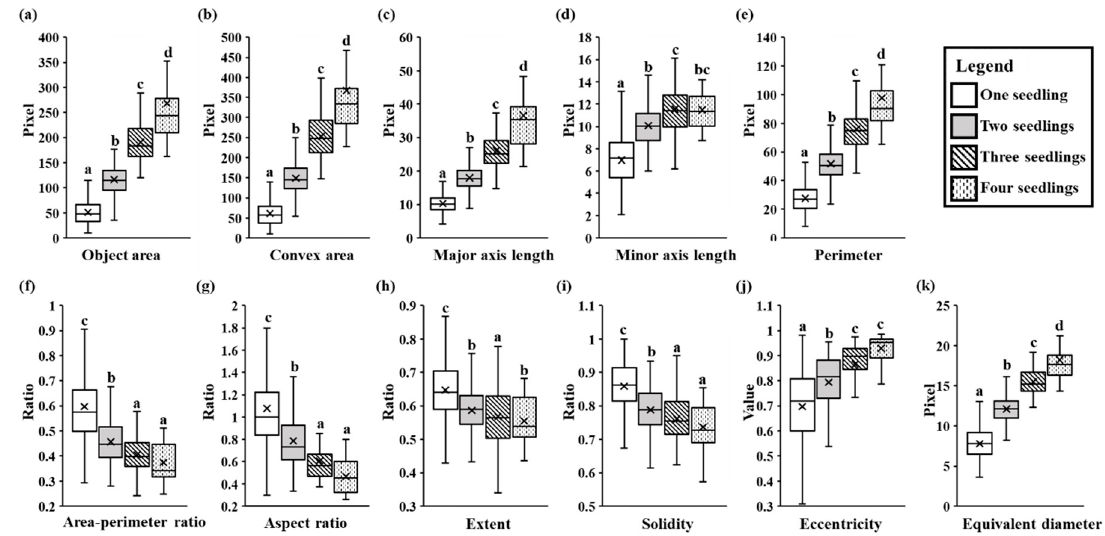
Figure 7. Boxplot of each ROI feature for different numbers of cotton seedlings. The legend at the right upper applies to plots ( a – k ) and represents the number of cotton seedlings in each ROI. Different lower-case letters indicate a significant difference at the 5% level of the ANOVA test.